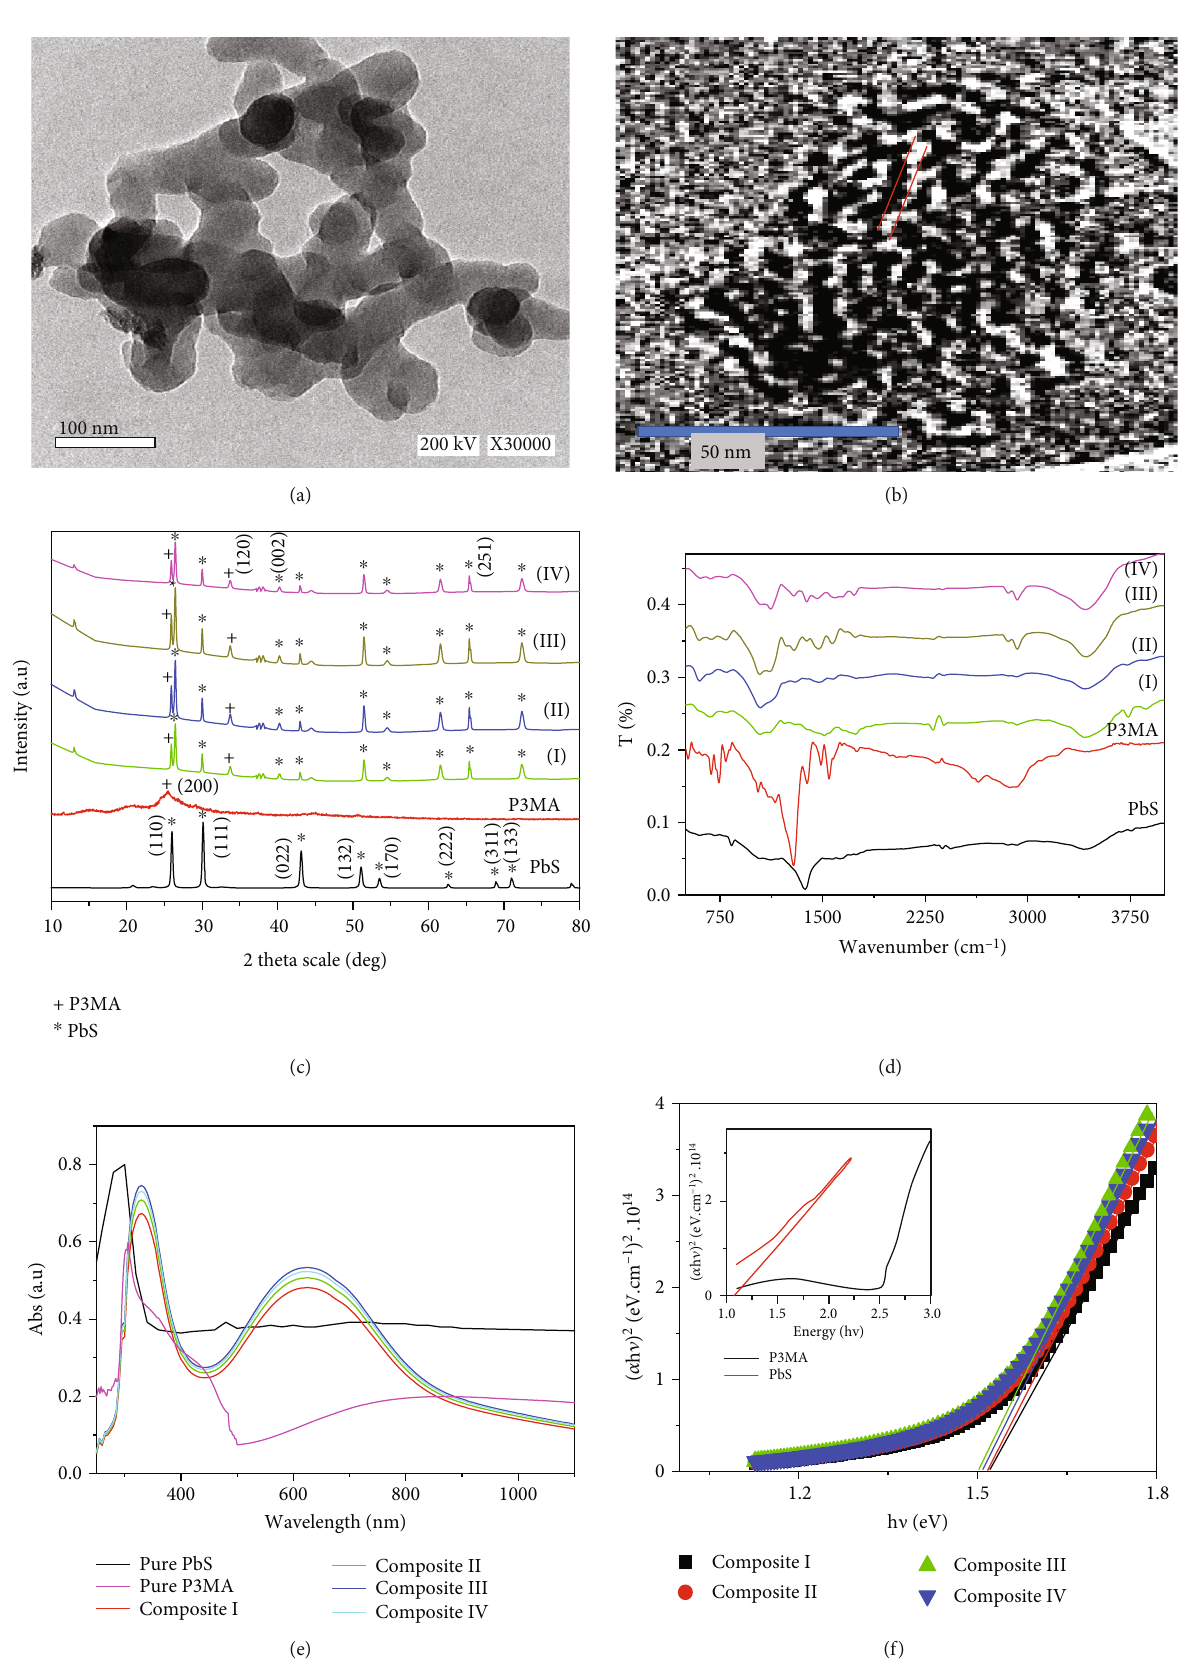
Figure 4: (a and b) TEM of composite III under di ff erent scale pares. (c) The XRD, (d) FTIR, (e) optical absorbance, and (f) band gap for P3MA, PbS, and P3MA/PbS-QD composites I, II, III, and IV under di ff erent Pb 2+